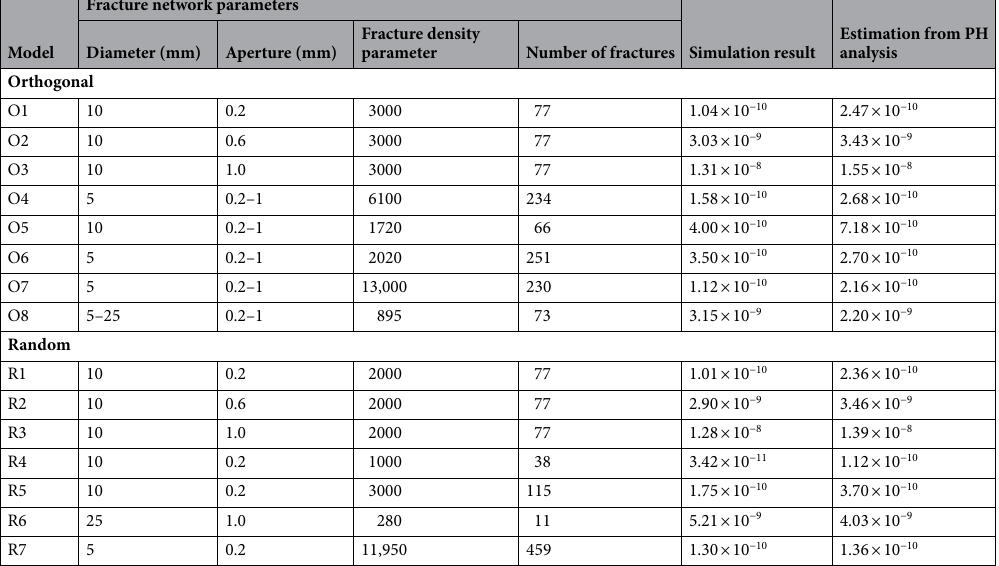
Table 1. Fracture network parameters and results of permeability. The correlation coefficients between simulation results and PH estimation for orthogonal distribution and random distribution were 0.994 and 0.992, respectively.